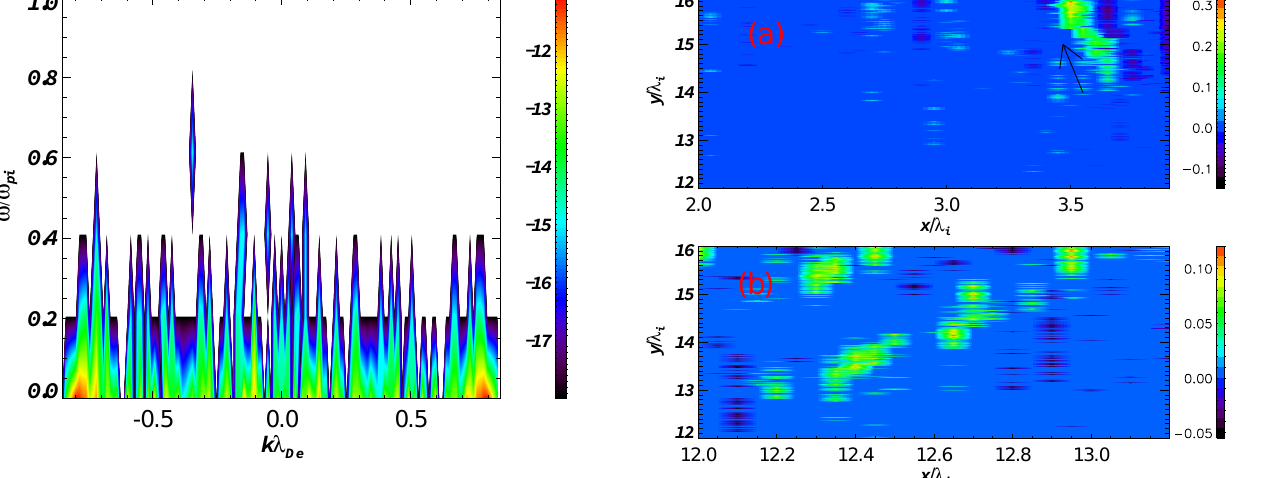
Figure 4. The time evolution of the DL shown in Fig. 1b at y/λ i = 6 . 75 (a) and the DL found in the separatrix near the X line (b) .